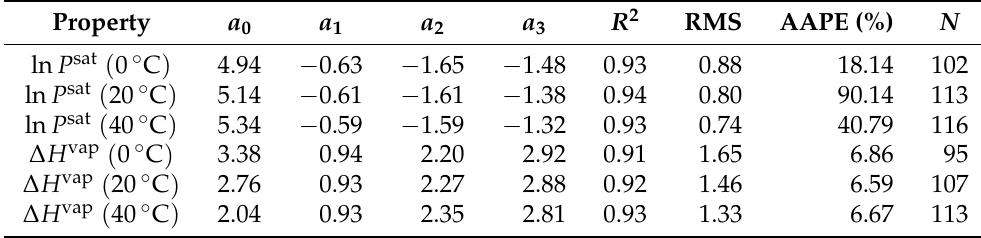
Table 1. Summary of the regressed model parameters using Equations (13) and (16) along with the Pearson correlation coefficient ( R 2 ), the root-mean-squared error (RMS), and the average absolute percent error (AAPE) to assess the goodness of fit, where N corresponds to the number of organic compounds included in the fit. In the correlations, P sat is in units of bar and ∆ H vap corresponds to ∆ H vap / ( RT ) , which is dimensionless. The temperature indicates the temperature at which the regression was